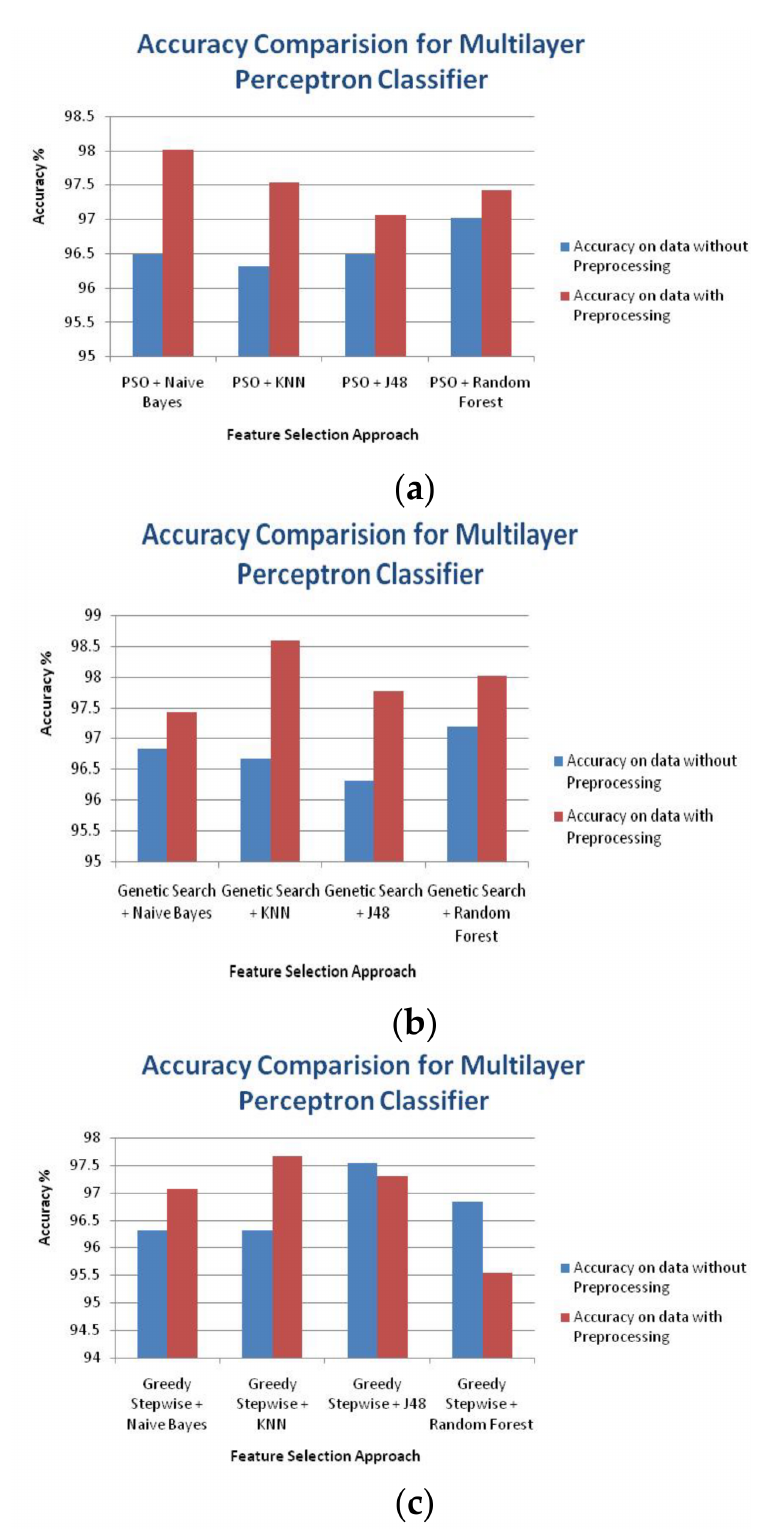
Figure 4. Accuracy comparison of Multilayer Perceptron Classifier for ( a ) PSO features selec- tion algorithm; ( b ) Genetic Search features selection algorithm; ( c ) Greedy Stepwise features selection